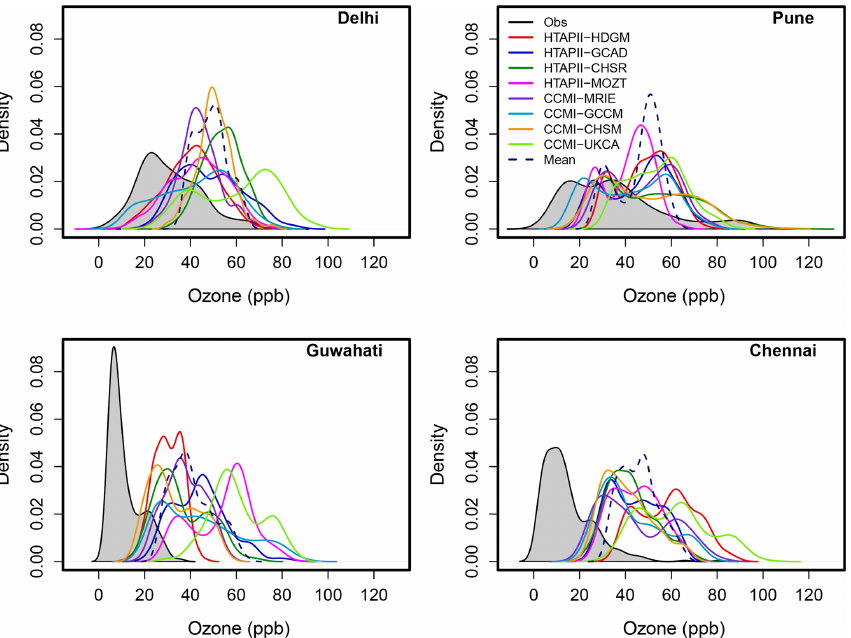
Figure 7. Probability density functions (PDFs) for in situ observations and model-simulated 24h average surface ozone at Delhi, Pune, Guwahati and